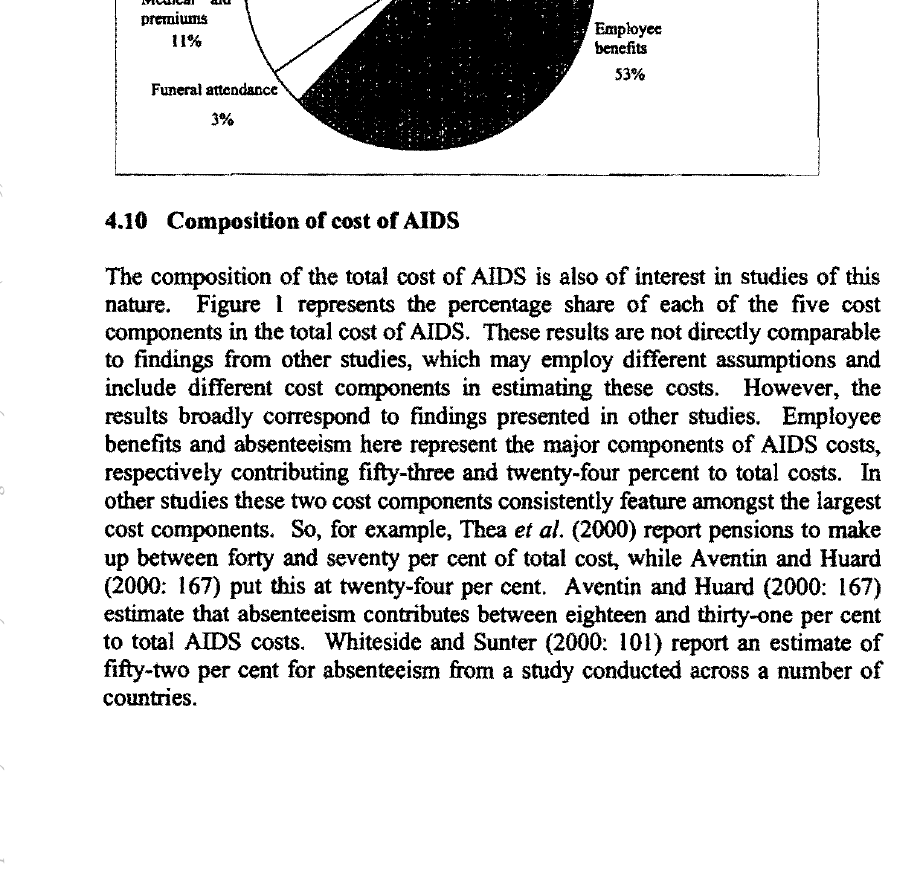
Recruitment and